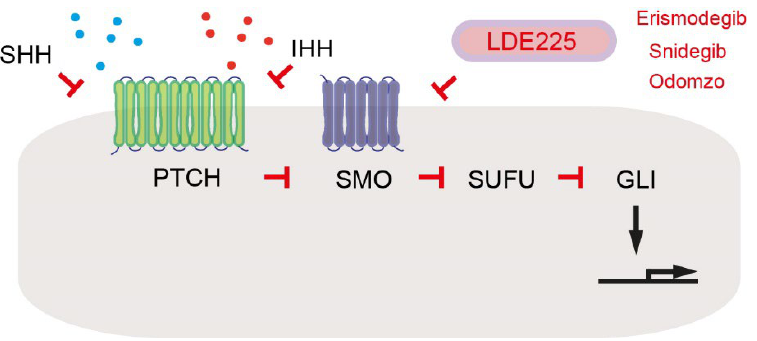
Figure 2. Hedgehog signaling. Arrows indicate activation or induction. Inhibition symbols are colored in red.